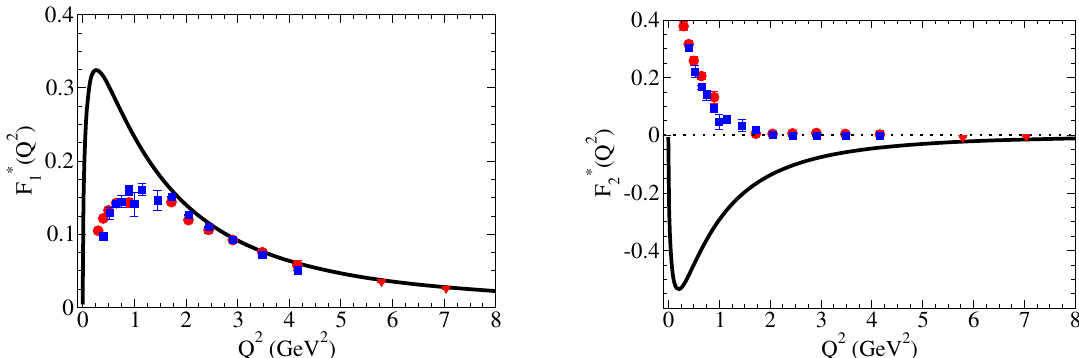
Figure 5. γ ∗ N → N (1535) Dirac transition form factor. Data from JLab (circles and triangles) [6, 45, 54] and MAID (squares) [3].